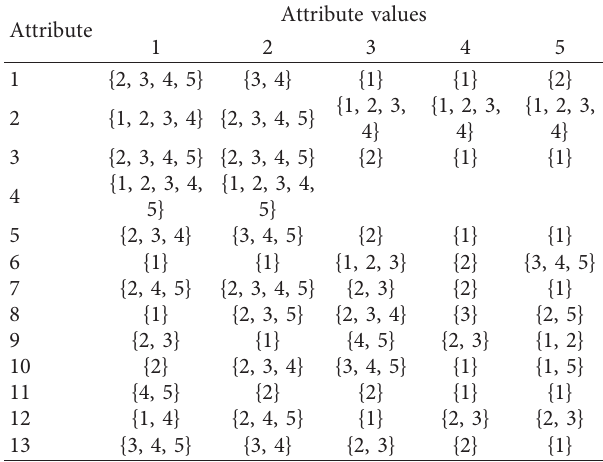
Table 9: Support sets of the attribute values of the Boston housing dataset for the customer having low customer satisfaction (1). The